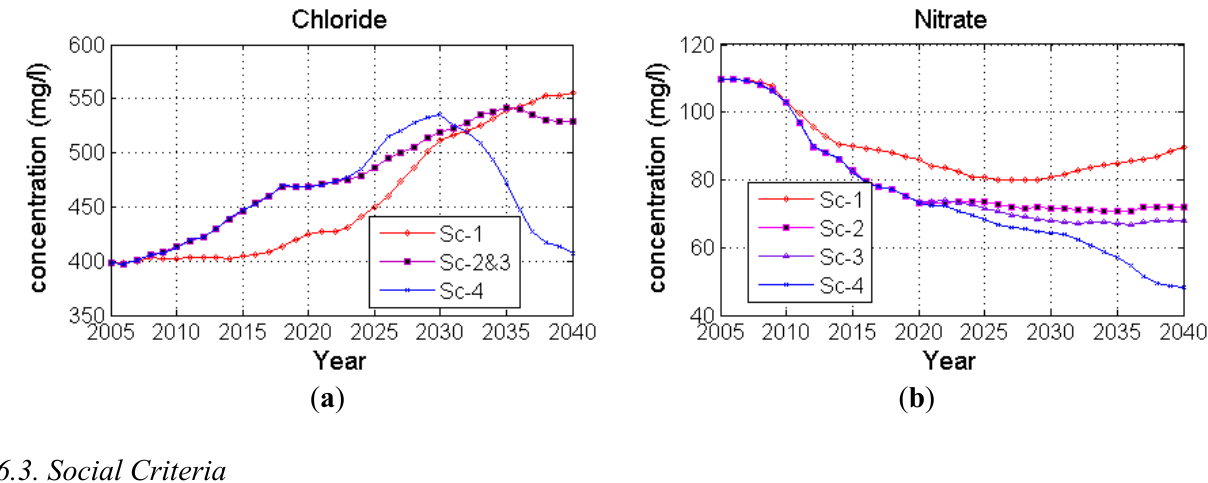
Figure 5. ( a ) Average chloride concentration; ( b ) Average nitrate concentration in the ten domestic wells for the entire simulation period (year 2005 to year 2040).